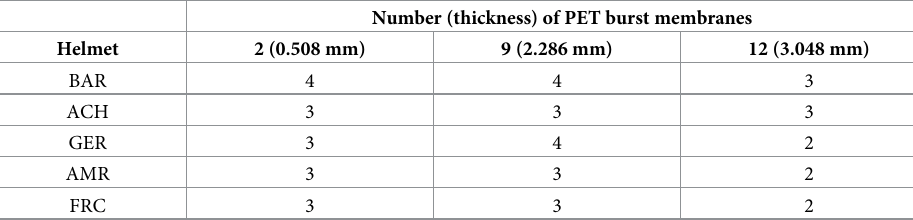
Table 2. Number of blast tests performed for each case, 46 in